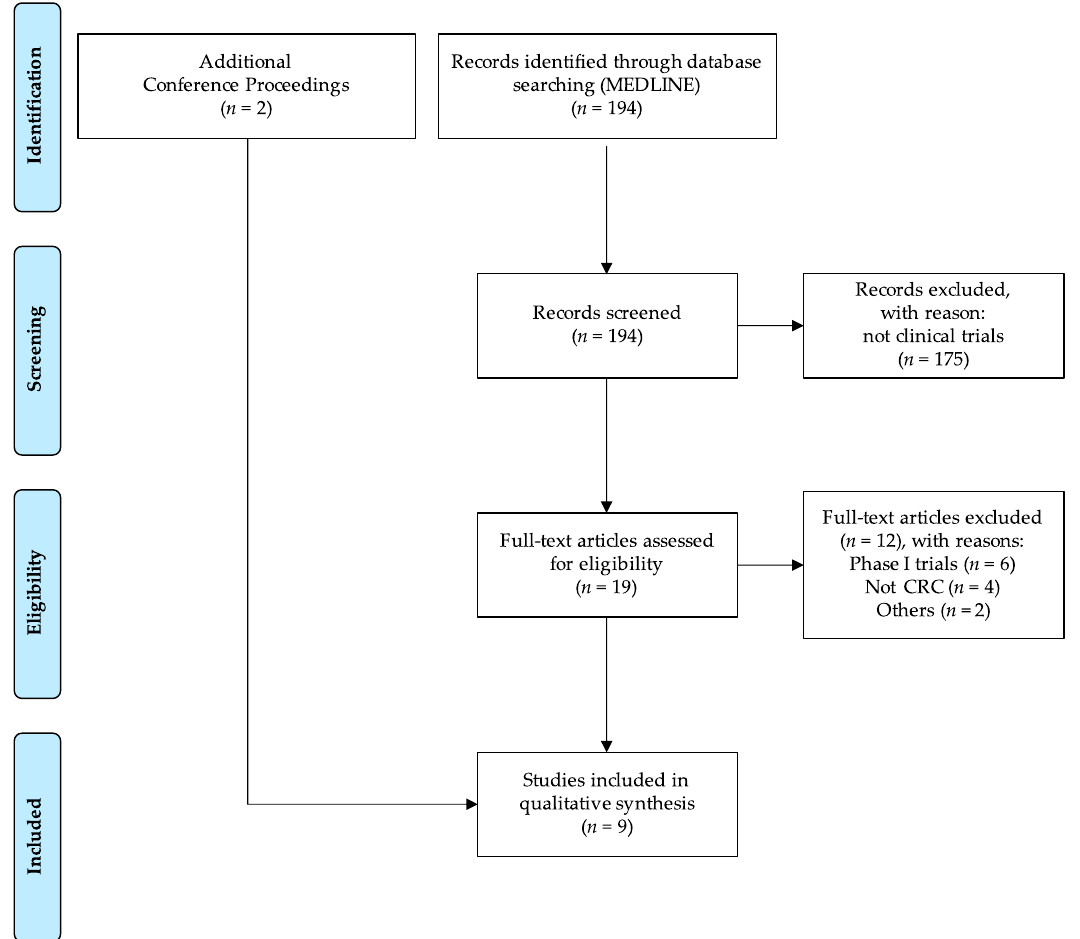
Figure 1. Consort flow diagram of studies reviewed; CRC, colorectal cancer.